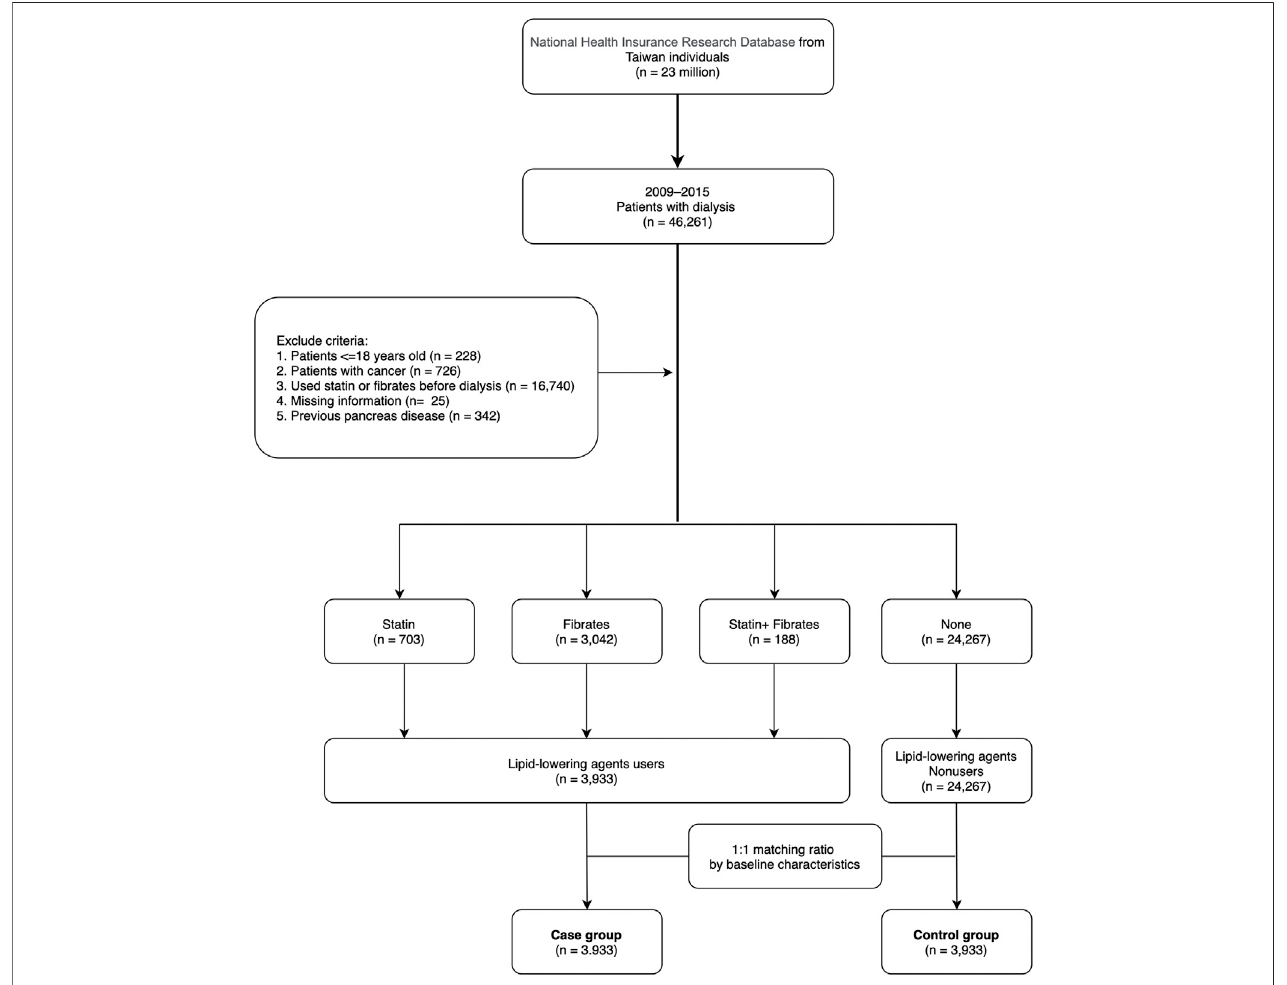
FIGURE 1 | Schematic of patient enrollment in the